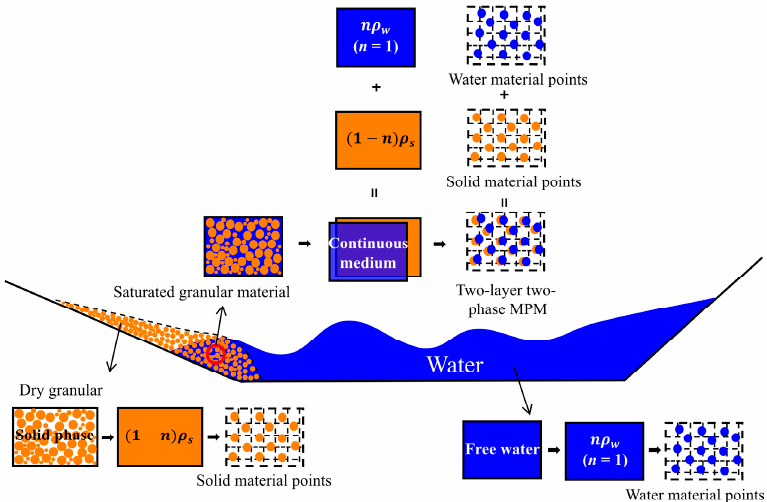
Figure 1. Diagram of the two – phase MPM based on the mixture theory.